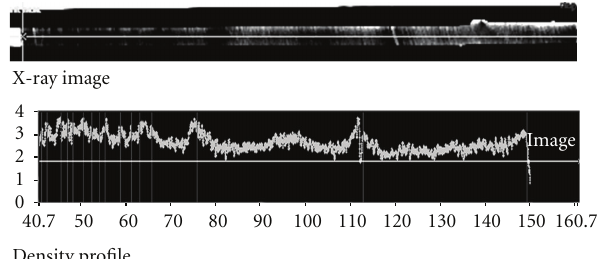
Figure 2: An example of X-ray image and density profile of an increment